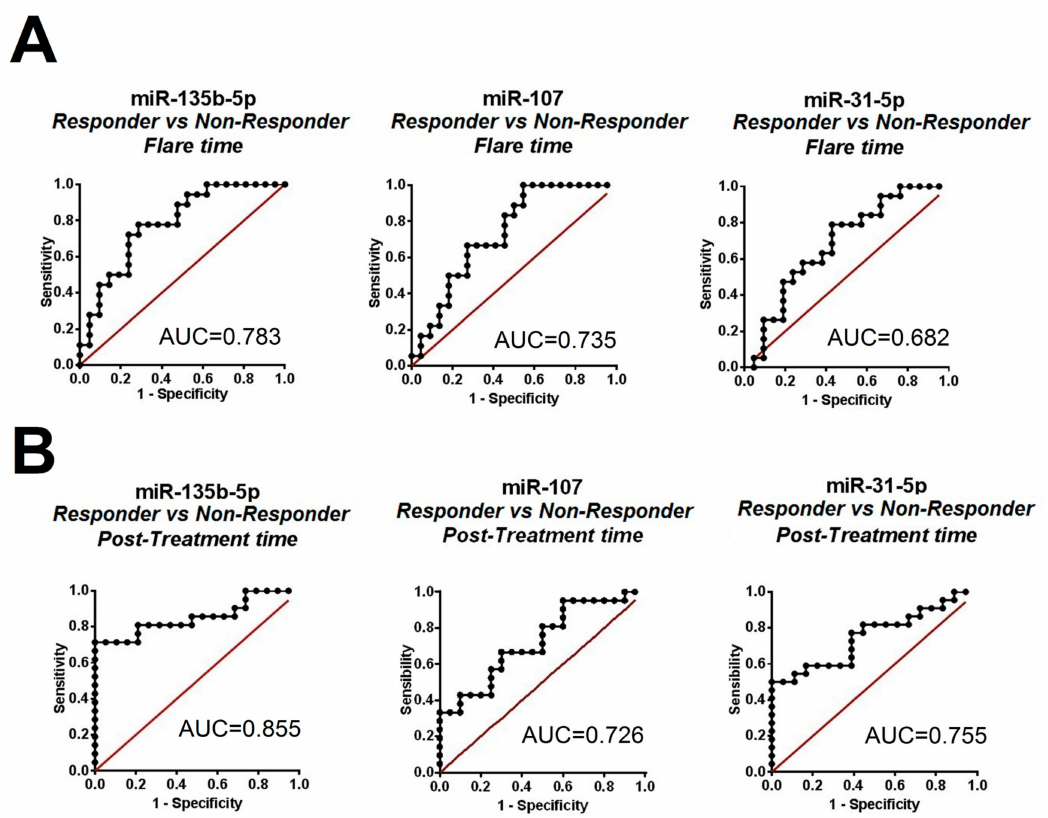
Figure 2. Di ff erentially expressed microRNAs (miRNAs) according to treatment response. Receiver operator characteristic analysis (ROC) of individual miRNAs to distinguish responder from non-responder patient groups. Analysis from samples obtained at flare time ( A ) and at post-treatment time ( B ). The value of the area under the curve (AUC) is shown in each